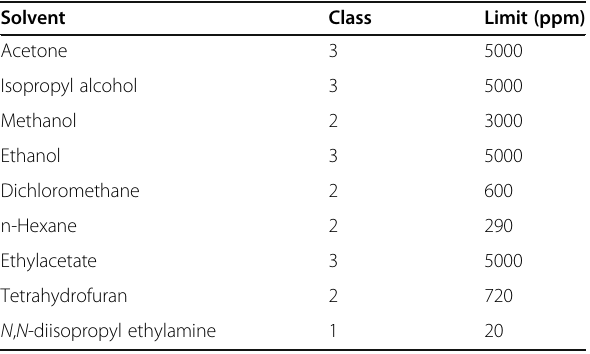
Table 1 Residual solvent with their class and limits Solvent Class Limit (ppm) Acetone